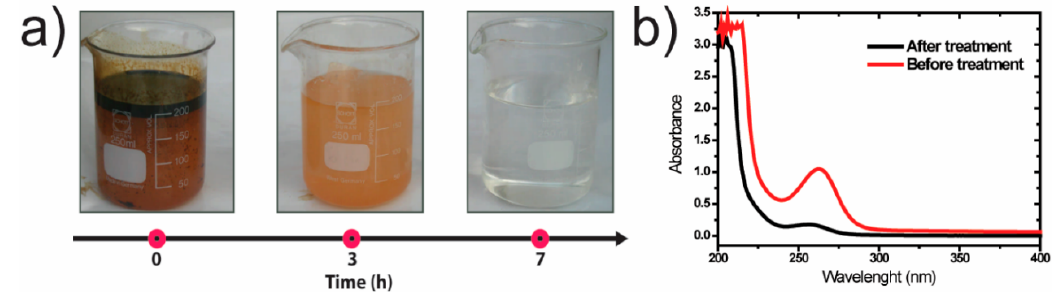
Figure 3. ( a ) The appearance of the oily wastewater along with the treatment with the 8 wt.% TiO 2 / P(VDF–TrFE) nanocomposite membrane in the solar photoreactor; ( b ) UV–vis absorption spectrum before and after the photocatalytic treatment of oily water after 7 h under sun irradiation/